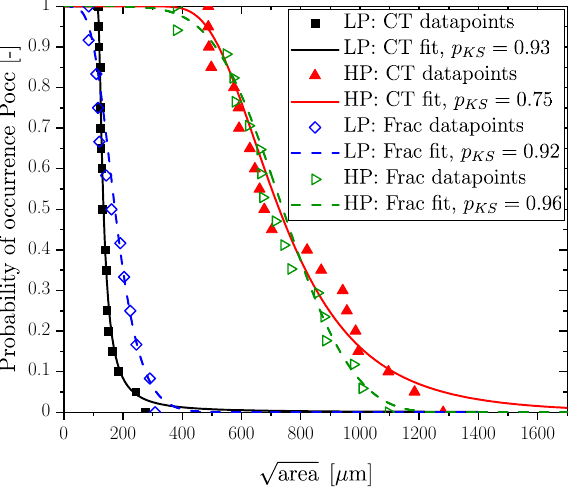
Figure 14. Comparison of cumulative defect distribution by fractography with CT results. Table 6. Comparison of fractography and computed tomography.